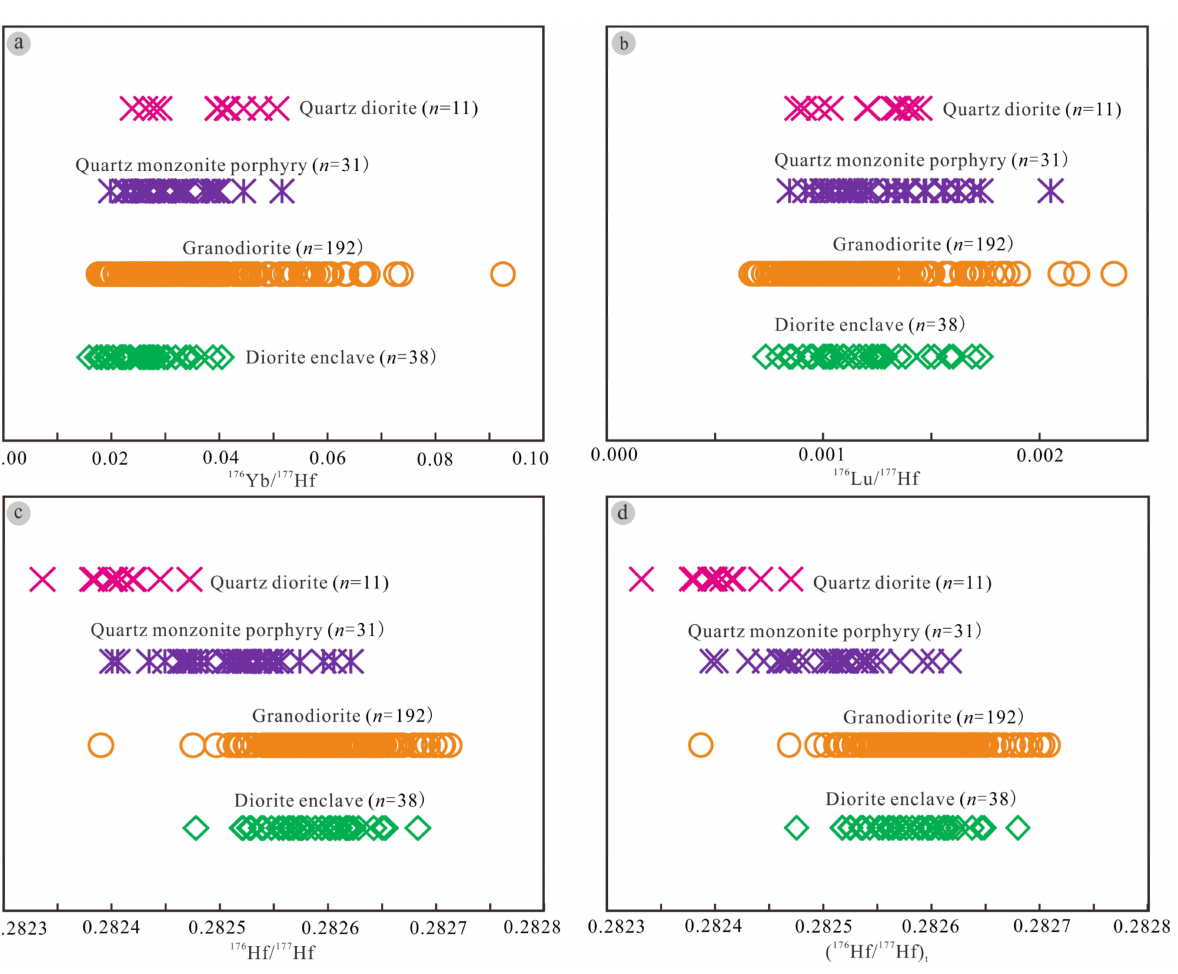
Figure 9. The diagram of variations ( a ) 176 Yb/ 177 Hf, ( b ) 176 Lu/ 177 Hf, ( c ) 176 Hf/ 177 Hf, and ( d ) ( 176 Hf/ 177 Hf) t from zircons in the Yangla granitoid intrusions. In summary, the quartz diorite, granodiorite, dioritic enclaves, and quartz monzonite porphyry have similar characteristics in terms of their 176 Yb/ 177 Hf and 176 Lu/ 177 Hf ratios but show evident differences in their 176 Hf/ 177 Hf, ε Hf ( t ), t DM , and t C DM values. This may be related to the differences in emplacement age, magma source, and evolutionary processes of each granitoid pluton. The reasons for the differences in the Lu-Hf isotopic system of the Yangla granitoids will be discussed in the following Section